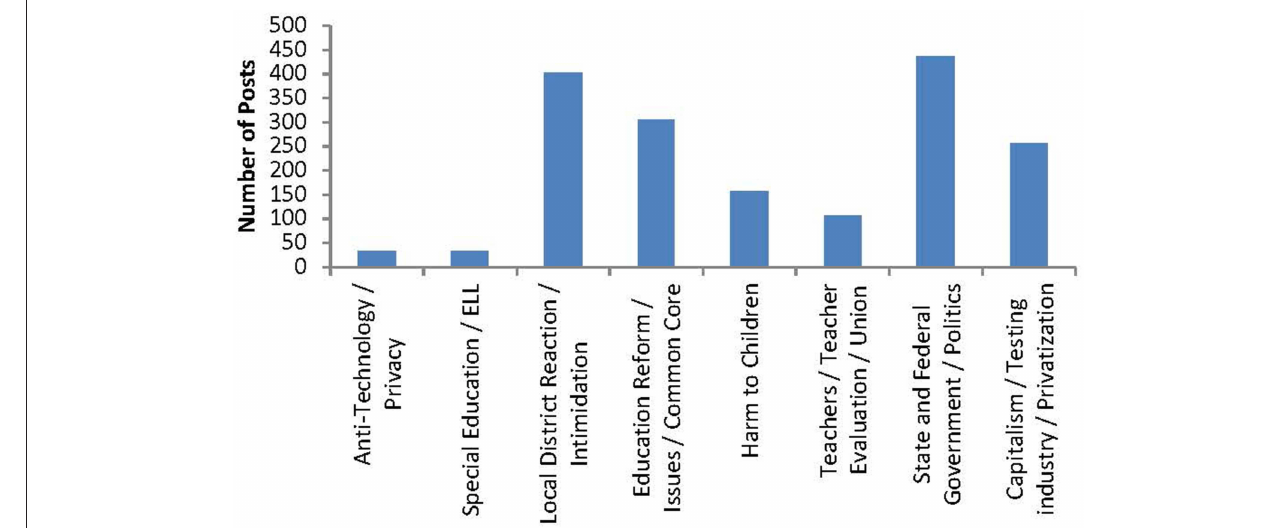
FIGURE 5 | Theme of Facebook